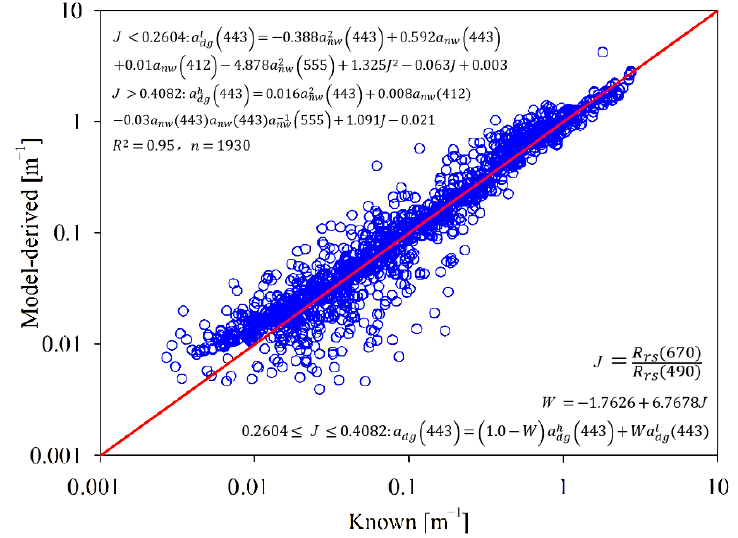
Figure 2. Optimal TAA model for a dg (443) prediction initialized from the IOCCG and NOMAD datasets.